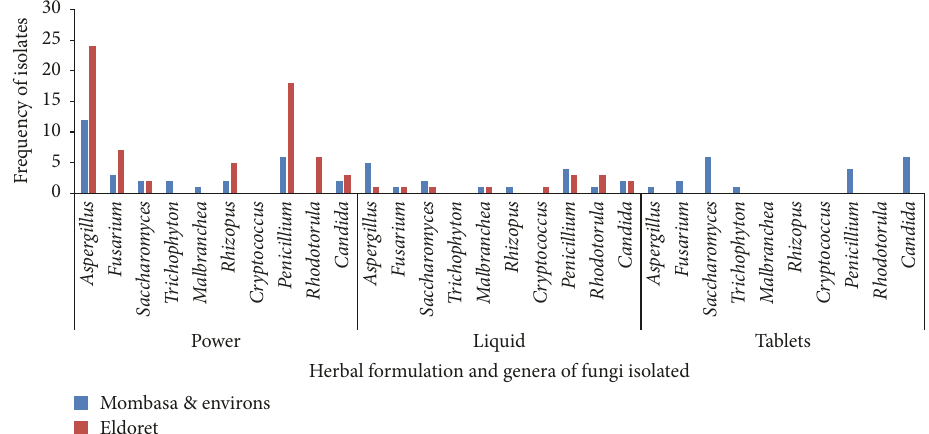
Figure 2: Fungi isolated from the different formulations of herbal products from Eldoret and Mombasa. Table 2: Analysis of aflatoxin and fumonisin for Eldoret and Mombasa samples using Student’s 𝑡 -test ( 𝑛 -100). One-sample